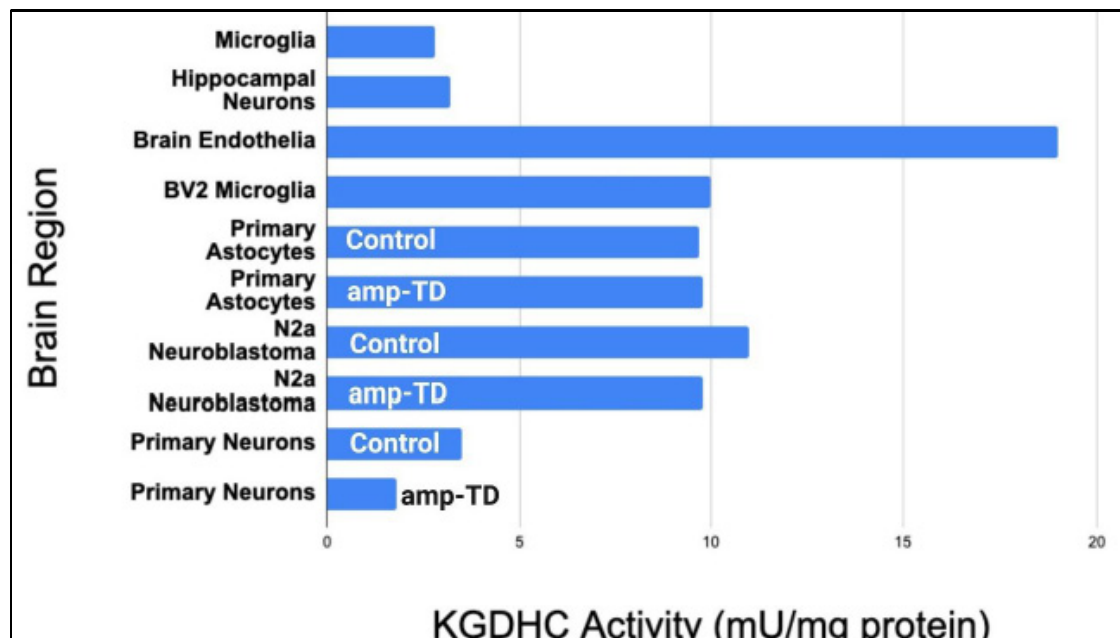
Figure 3. Activities of α -ketoglutarate dehydrogenase complex (KGDHC) and the response to thiamine deficiency (TD) vary between types of brain cells. Brain endothelial cells have the highest activity of KGDHC, while the hippocampal neurons have the lowest activity. KGDHC activity in neurons was the most responsive to TD produced by the thiamine transport inhibitor amprolium. A deficiency of thiamine, the precursor of the co-factor thiamine pyrophosphate, pro- duces selective neuron death but activates other cell types (Figure 3). The unique distri- bution of KGDHC activity does not account for the selective response to thiamine defi- ciency. TD slightly inhibits general cellular dehydrogenases in all cell types, whereas it cell types tested, only in neurons did thiamine deficiency induce apoptosis and cause the accumulation of 4, hydroxy-2-nonenal, a lipid peroxidation product [90]. Thus, in vivo and in vitro, thiamine deficiency kills neurons and activates other cell types [90]. 5. KGDHC and Cell Signaling by Reactive Oxidative Species (ROS) KGDHC is central to cell signaling regulated by reactive oxygen species (ROS). ROS regulates hundreds of cell processes. Uniquely, KGDHC is both regulated by ROS and produces ROS (Figure 4). The data strongly indicates that the E3 subunit of KGDHC is a primary site of